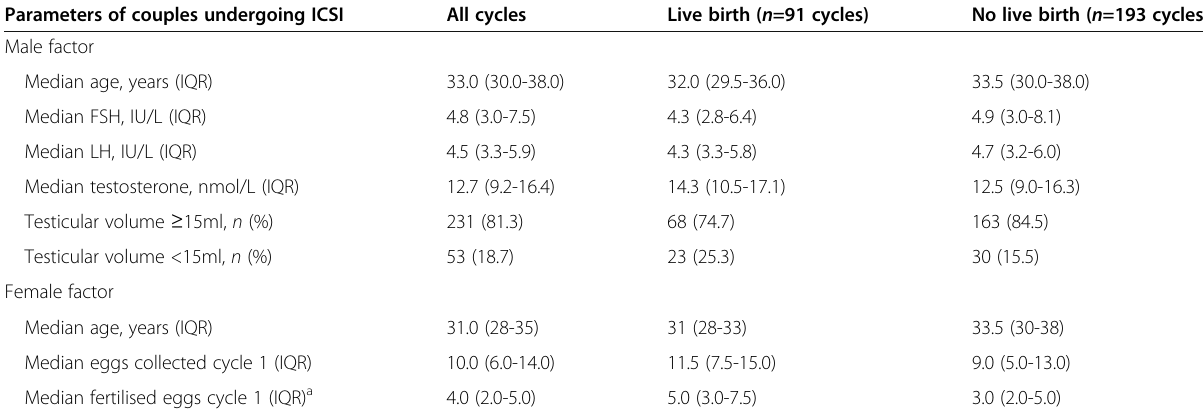
Table 2 The descriptive statistics of parameters of couples undergoing ICSI after successful TESE, comparing those cycles with a live birth to those without a live birth Parameters of couples undergoing ICSI All cycles Live birth ( n =91 cycles)